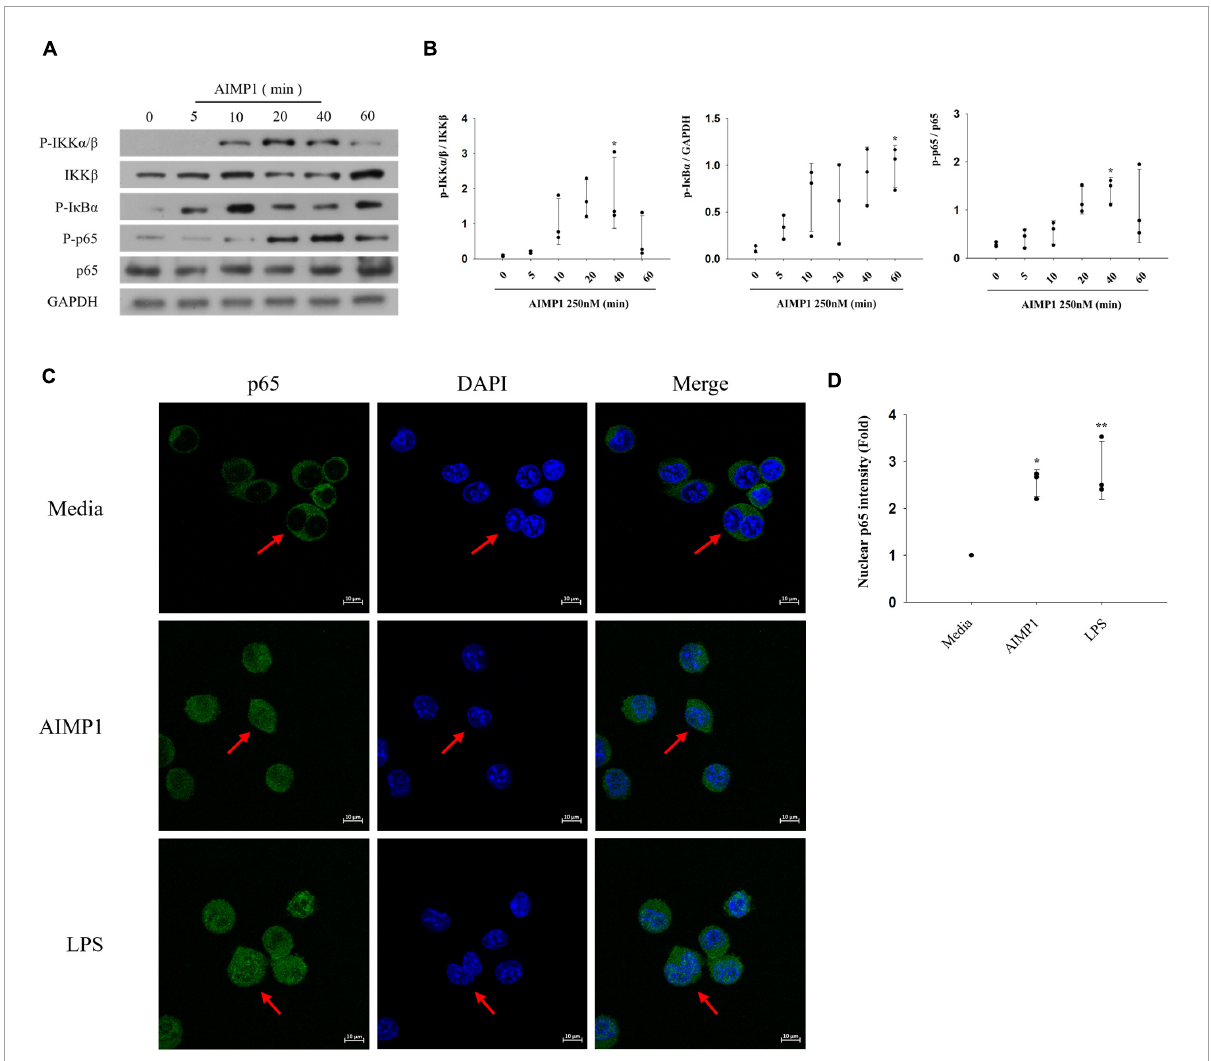
FIGURE4 ARS complex-interacting multifunctional protein 1 (AIMP1) activates BV-2 cells via the nuclear factor-kappa B (NF- κ B) pathway (A,B) BV-2 cells were incubated with AIMP1 (250 nM) in a time-dependent manner. IKK β , p65, and phosphorylated forms of IKK α / β , I κ B- α , p65 were quantified by western blotting analysis. GAPDH served as a control. (B) Scatter plots represent the phosphorylation ratio of NF- κ B proteins. It shows the mean ± SD of three independent experiments. (C,D) Translocation of NF- κ B p65 into the nucleus was observed by confocal microscopy. The representative data are shown. (D) Scatter plots represent the fold ratio based on the fluorescence intensity of nuclear p65 in the medium group. It shows the mean ± SD of three independent experiments. Statistical significance was evaluated using one-way ANOVA with a Bonferroni post hoc test for multiple comparisons; * P < 0.05 and ** P < 0.01 compared to the medium